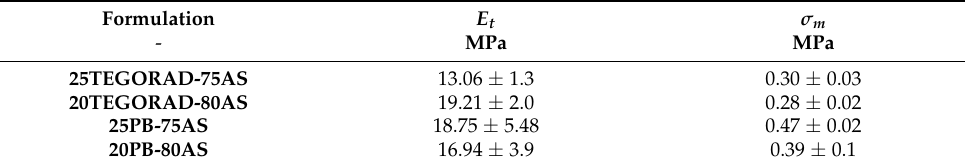
Table 6. Multilayer tensile testing results (inert).